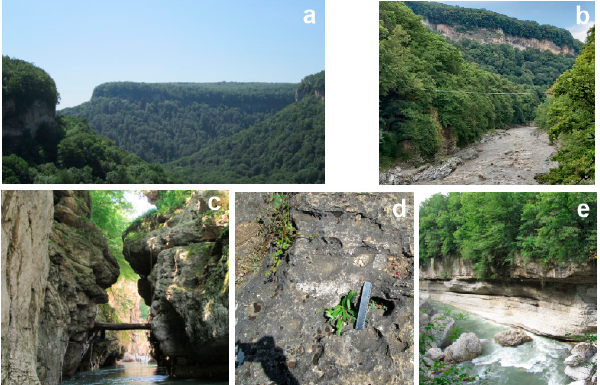
Figure 3. Geoheritage of the study area (part 1): a —general view of the Khadzhokh Canyon and its branches, b —the central part of the Khadzhokh Canyon, c —the KhadzhokhKlamm, d —minor the